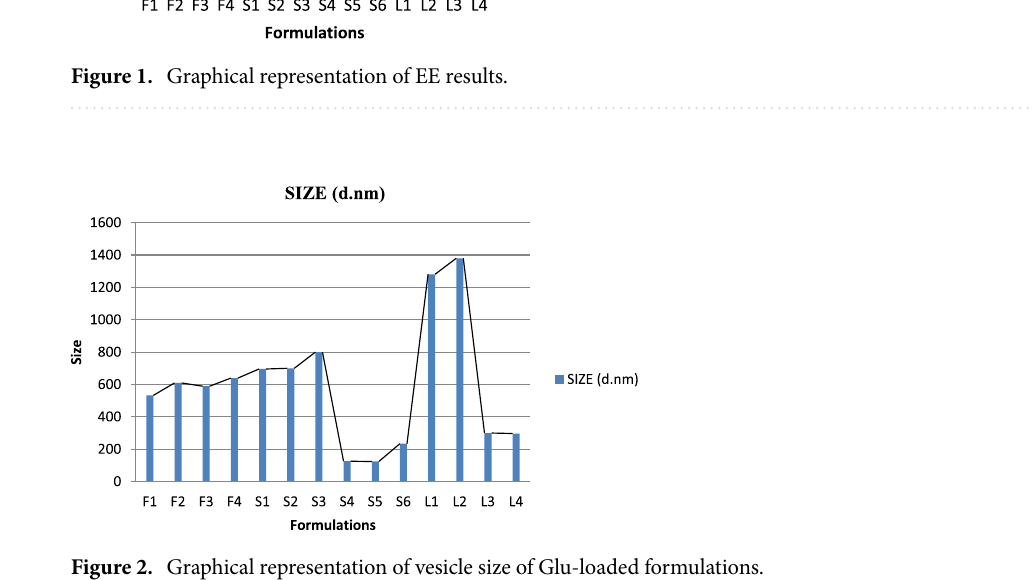
Figure 2. Graphical representation of vesicle size of Glu-loaded formulations.